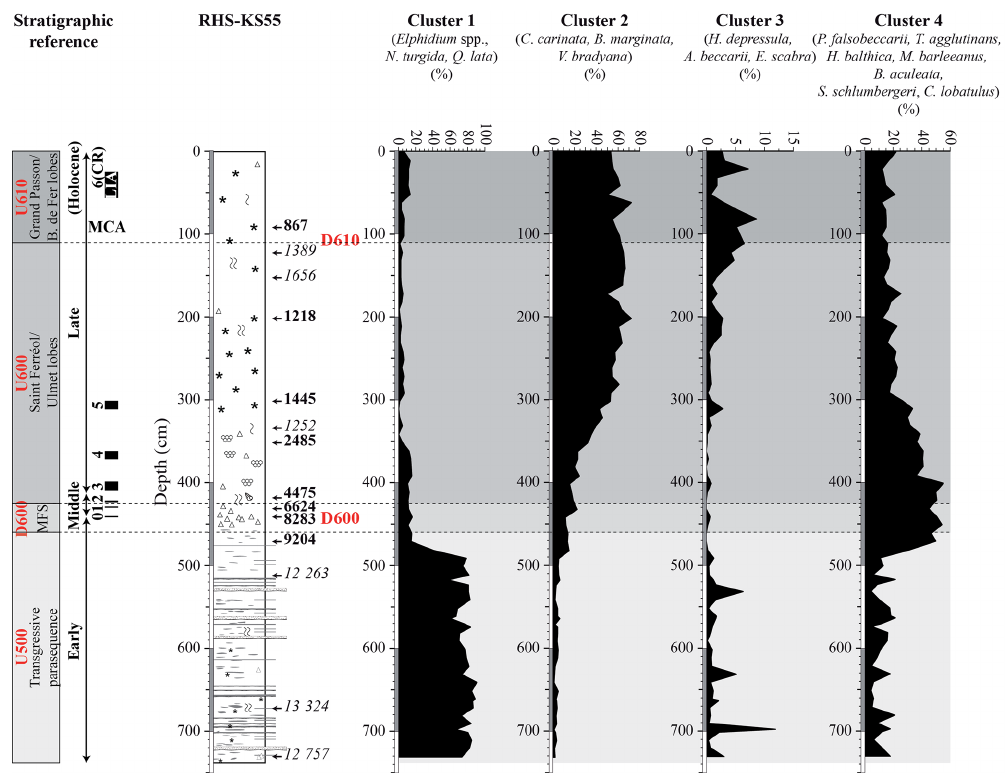
Figure 9. Cumulative percentages of taxa composing the defined benthic foraminiferal clusters along core RHS-KS55. Correlations with seismic units and discontinuities are shown on the left side of the figure. The corresponding positions of seismic units and discontinuities (U500, U600, U610, D600, and D610) are also reported on the plots (gray bands and dashed lines). Holocene cold relapses (CRs) are also indicated on the y axis by the black rectangles (left side of the